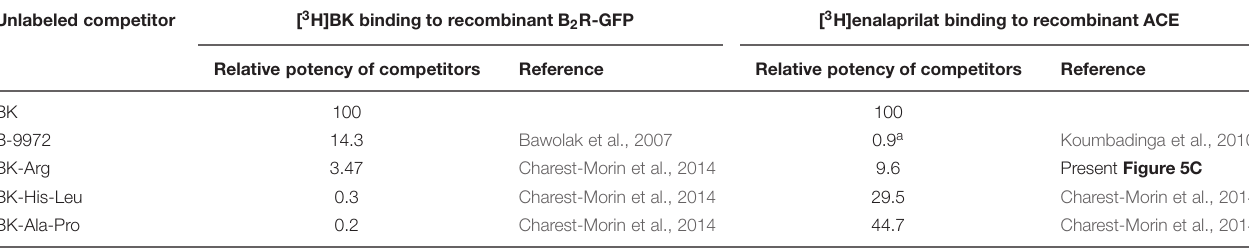
TABLE 1 | In vitro pharmacology of selected B 2 R agonists or BK homologs with C-terminal extensions established in radioligand binding competition assays. Unlabeled